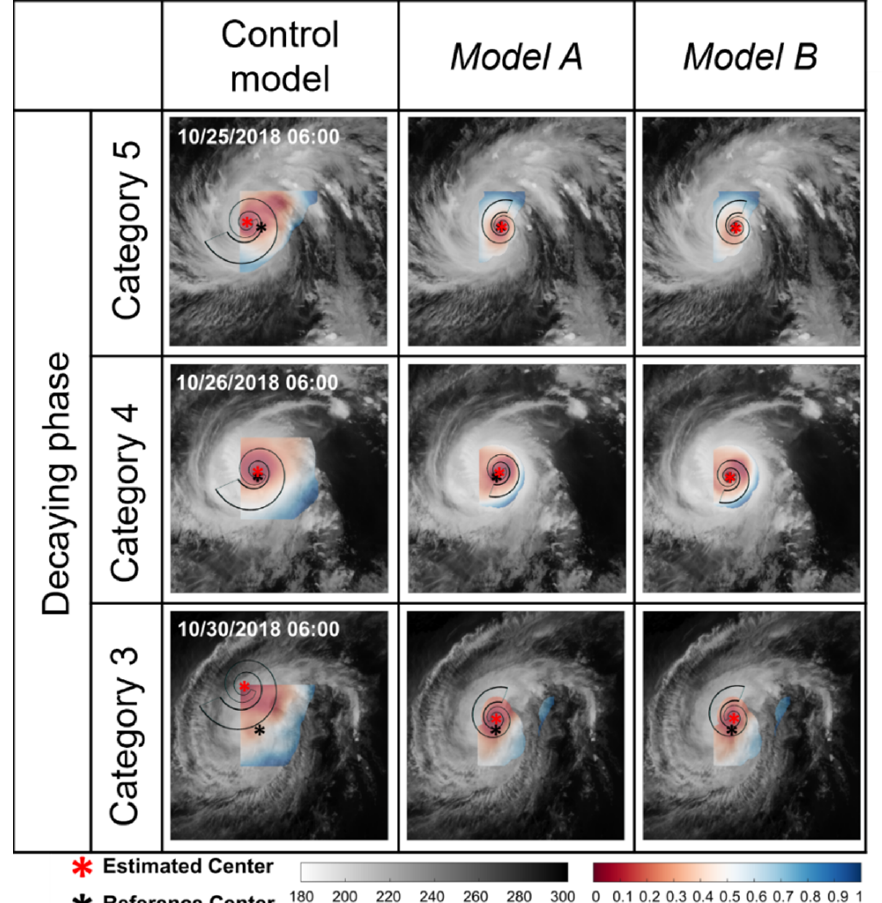
Figure 8. Tropical cyclone center location estimated by the scheme-2 -based control model and models A and B by category and phase. Communication, Ocean and Meteorological Satellite Meteorological Imager infrared-1-channel-based observations are used as background images, and regions of interest are shown in color. The color of regions of interest represents normalized Fmat values (0–1) at the IRW observation, and reddish color indicates lower Fmat . The black asterisks indicate the tropical cyclones center determined by the JTWC best track and the red asterisks represent the tropical cyclone center estimated by the control model and models A and B .